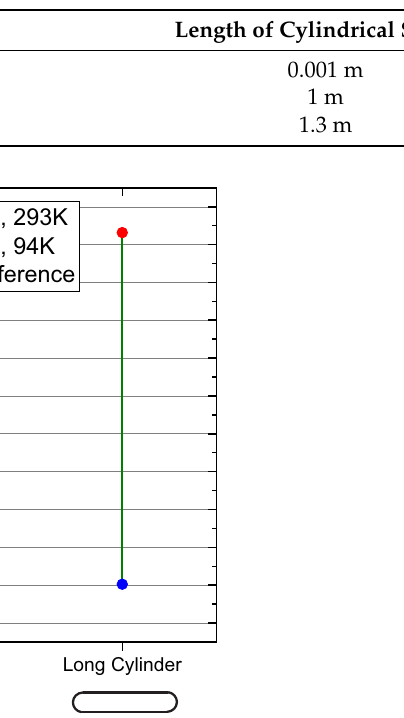
Table 7. Simulated tank geometries.